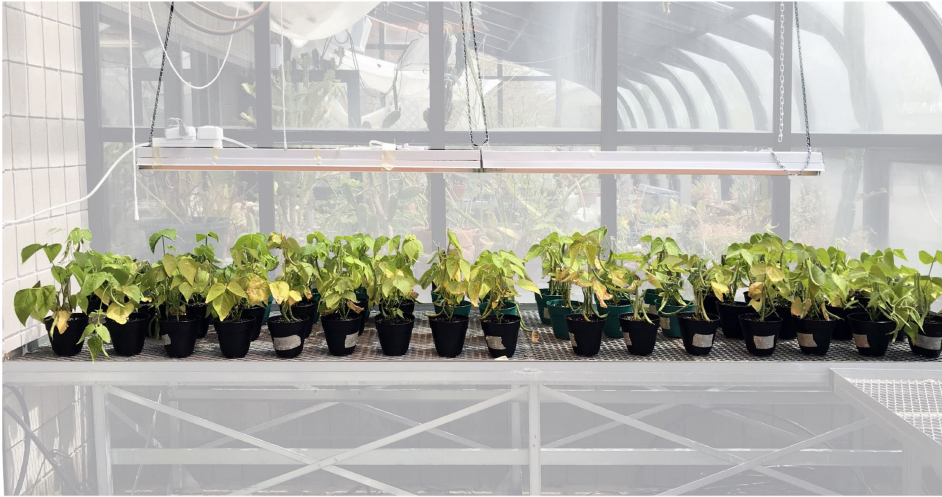
Figure 1. The experimental greenhouse environment—48 snap bean plants served as our test bed, with artificial lights providing additional light and heat, necessary for healthy plant